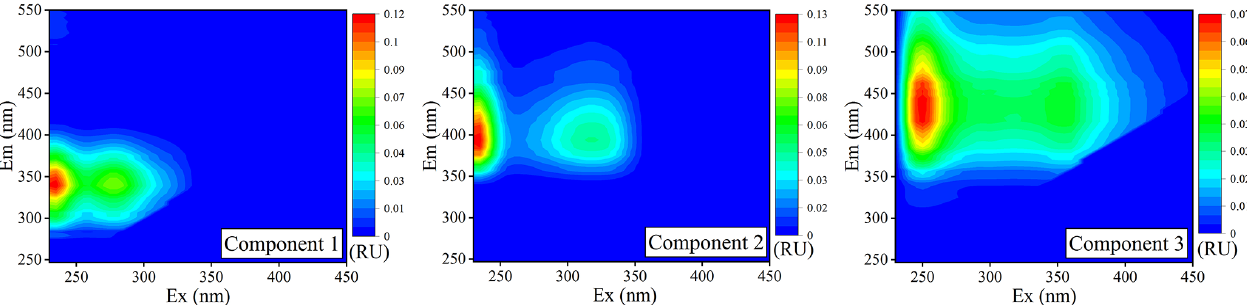
Figure 3. The EEM components derived from the PARAFAC model of WSOC in atmospheric PM 2 . 5 samples collected at the Chuzhou (CZ) and Guangzhou (GZ)